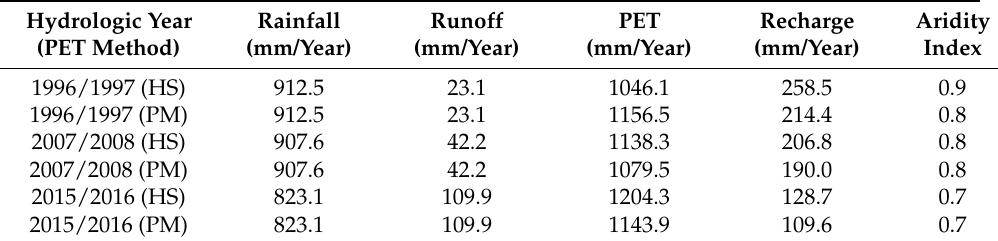
Table 10. Rainfall, PET, and Recharge for 1996/1997, 2004/2005, and 2017/2018 hydrological years for the Kimbiji Aquifer.